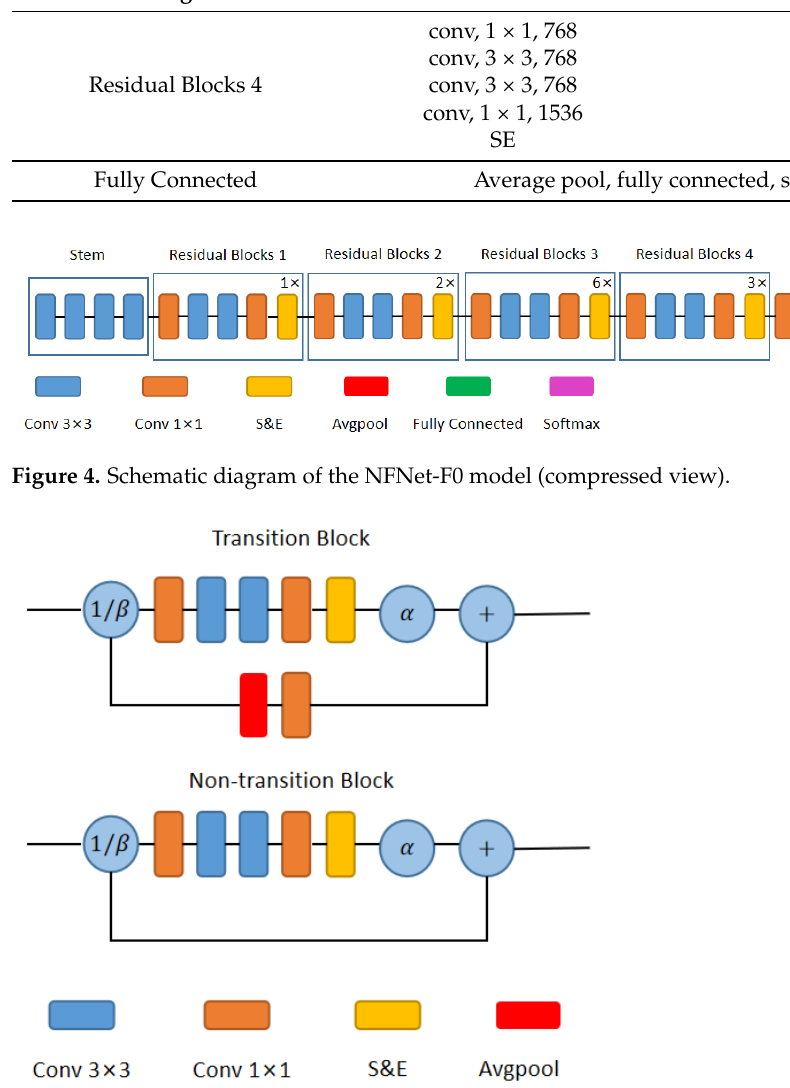
Figure 5. NFNet residual blocks (transition and